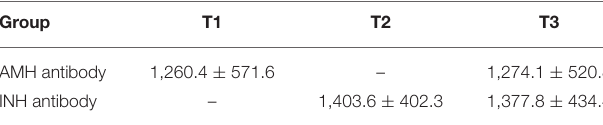
TABLE 3 | Anti-Müllerian hormone (AMH) and inhibin (INH) antibody titers. Group T1 T2 T3 AMH antibody 1,260.4 ±